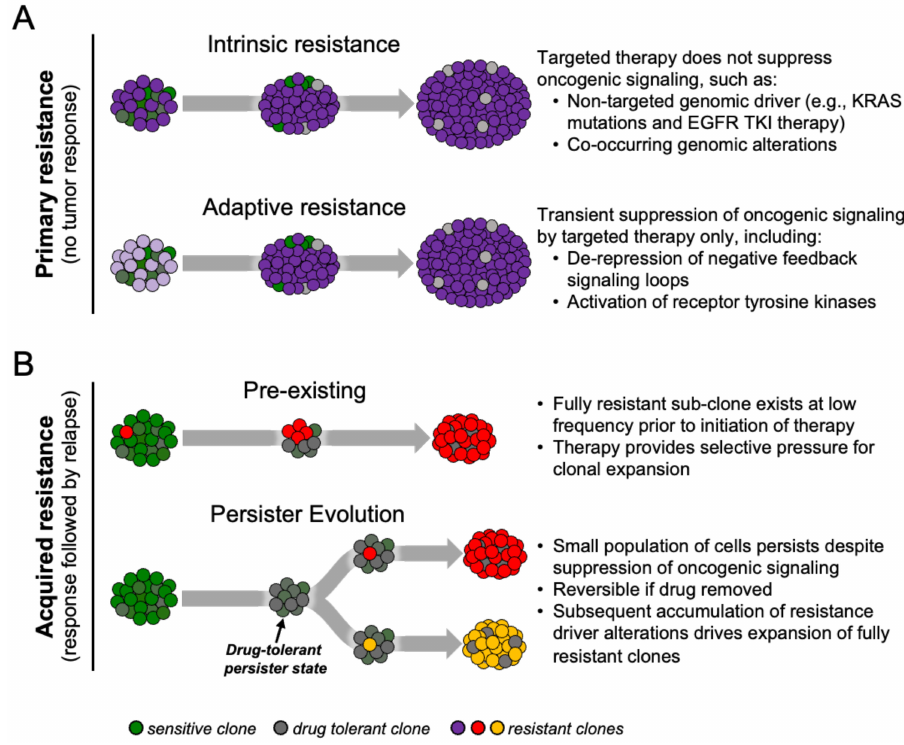
Figure 1. Resistance to targeted cancer therapies. Drug resistance can occur at the time of initial therapy (primary resistance) or develop after initial therapy response (acquired resistance). ( A ) Primary resistance may be due to intrinsic resistance resulting from ineffective targeting of the oncogenic driver such that oncogenic signaling is not suppressed (for instance, activating KRAS mutations confer resistance to EGFR targeted therapy). Alternatively, in adaptive resistance, cells rapidly rewire oncogenic signaling after initial suppression such that therapy does not induce death in the bulk of tumor cells. ( B ) In acquired drug resistance, disease relapse after initial therapy response may be driven by Darwinian selection of resistant clones that exist before treatment and expand under the selective pressure of therapy (for instance, rare T790M+ clones in some EGFR-mutant lung cancers), or evolution of drug-tolerant “persister” cells that acquire resistance mechanisms during the course of